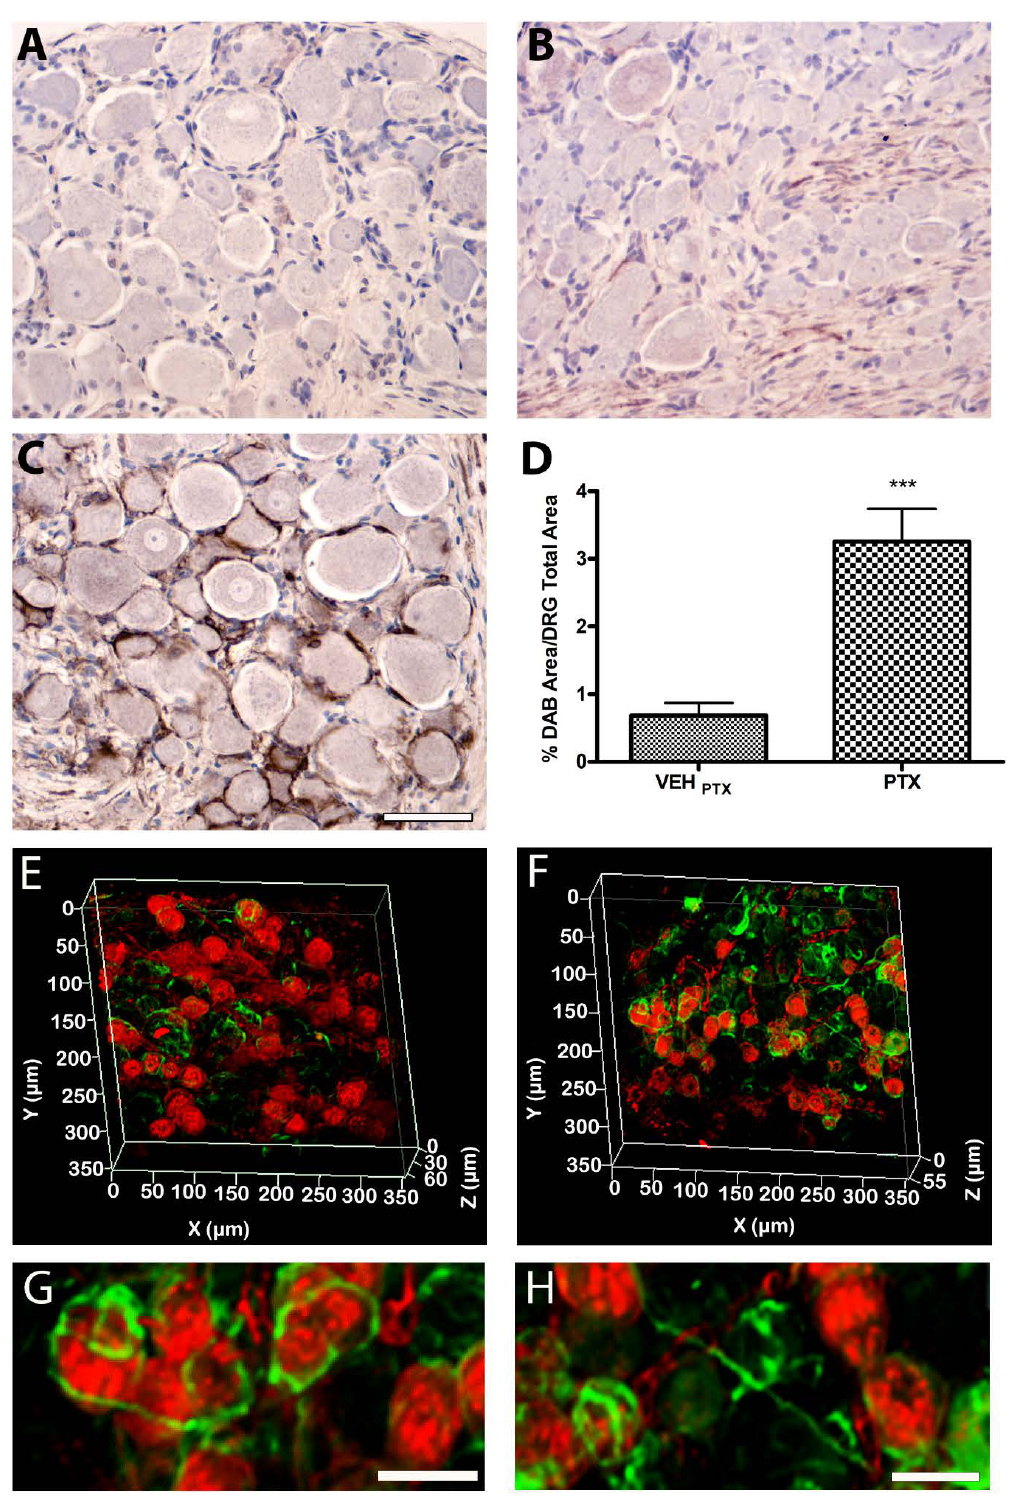
Figure 2. Analysis of the immunolocalization and expression of GFAP in the DRG. ( A – C ): immuno- histochemistry analysis; ( A ): cisplatin; ( B ): vehicle; ( C ): paclitaxel; bar = 100 µ m. ( D ): quantitative analysis of GFAP expression; ( E – H ): 3D-IF analysis (RED: IB4; GREEN: GFAP); ( E ): vehicle PTX ; ( F ): paclitaxel; ( G , H ): magnifications from ( F ); bar = 25 µ m. *** p <